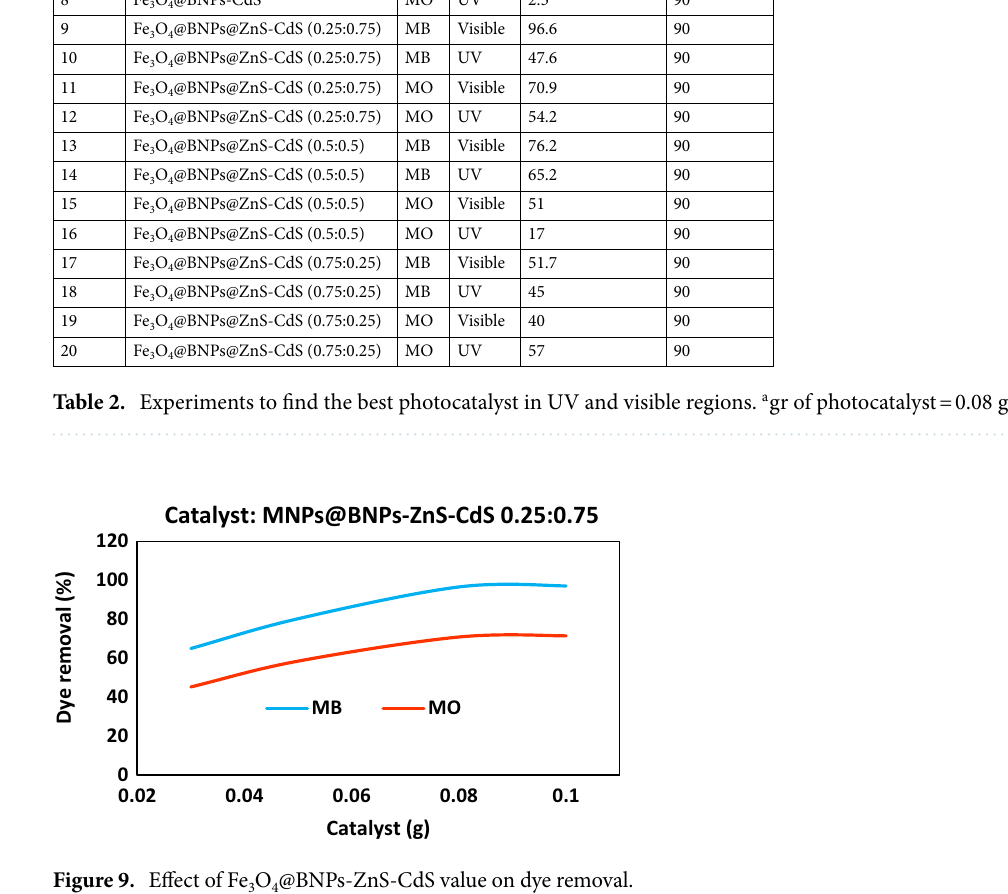
Figure 9. Effect of Fe 3 O 4 @BNPs-ZnS-CdS value on dye